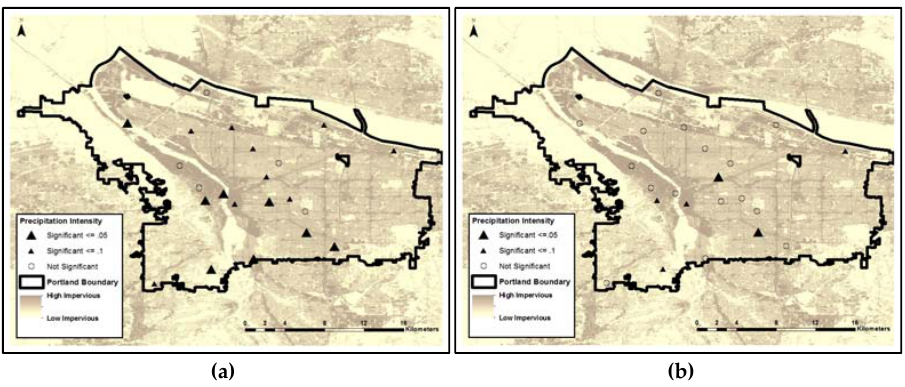
Table 1. Monthly Moran’s Index statistics. Items in bold represent months when field significance and increasing trends also occur.